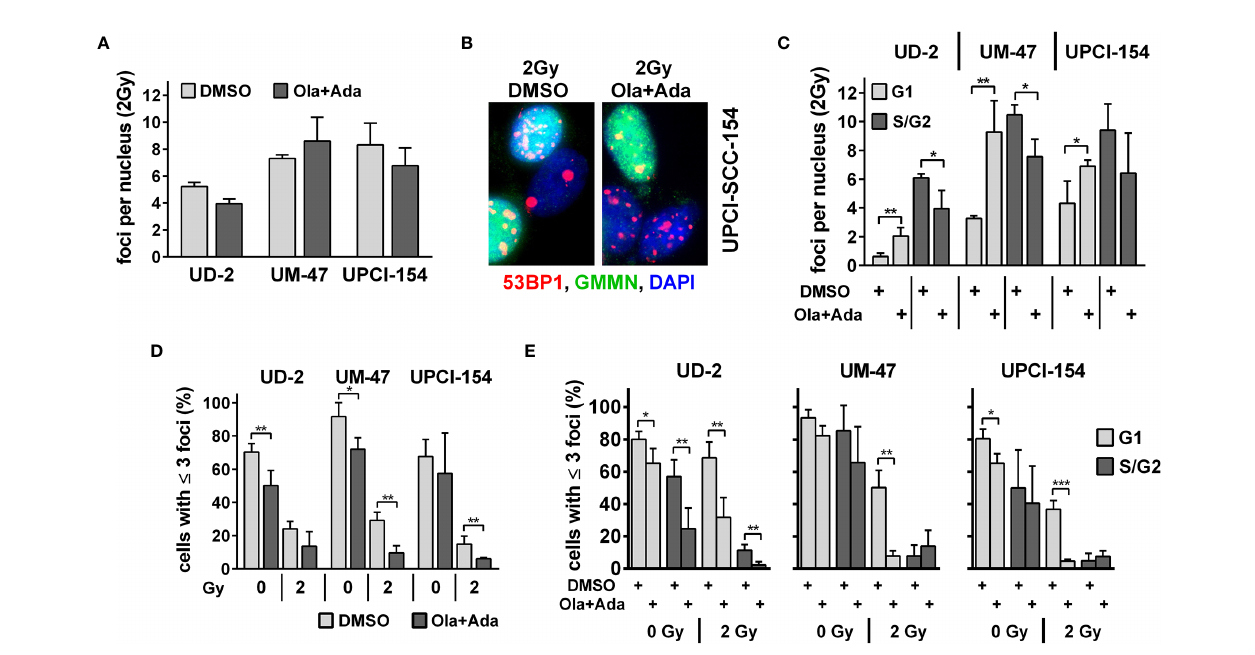
FIGURE 4 | Effect of PARP and Wee1 targeting on DSB repair. (A) Quanti fi cation of radiation-induced nuclear 53BP1 foci at 24 h after 2 Gy irradiation. Counts were normalized to the DNA content of the respective cell lines as assessed previously (33), foci numbers in non-irradiated controls were subtracted. (B) Example of immuno fl uorescence co-staining of 53BP1 and the S/G2 phase marker geminin (GMMN). (C) Quanti fi cation of radiation-induced nuclear 53BP1 foci with respect to the cell cycle phase as determined by geminin co-staining. Foci numbers in non-irradiated controls were subtracted. (D) Fraction of cells with ≤ 3 53BP1 nuclear foci. (E) Fraction of cells with ≤ 3 53BP1 nuclear foci with respect to cell cycle phase as determined by geminin co-staining. Signi fi cant changes are indicated with *, ** and *** indicating p < 0.05, p < 0.01, and p < 0.001, respectively (two-tailed Student ’ s